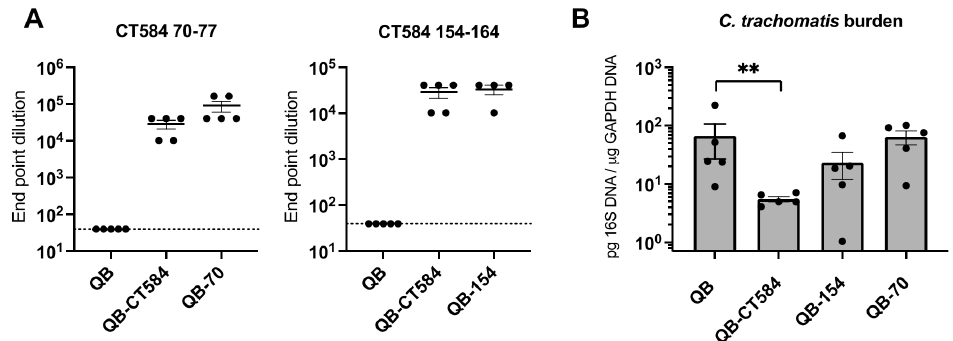
Figure 3. Immunogenicity and protective capacity of single epitope and mixed epitope vaccines against C. trachomatis T3SS tip protein CT584. ( A ) Immunization with Q β VLPs conjugated to